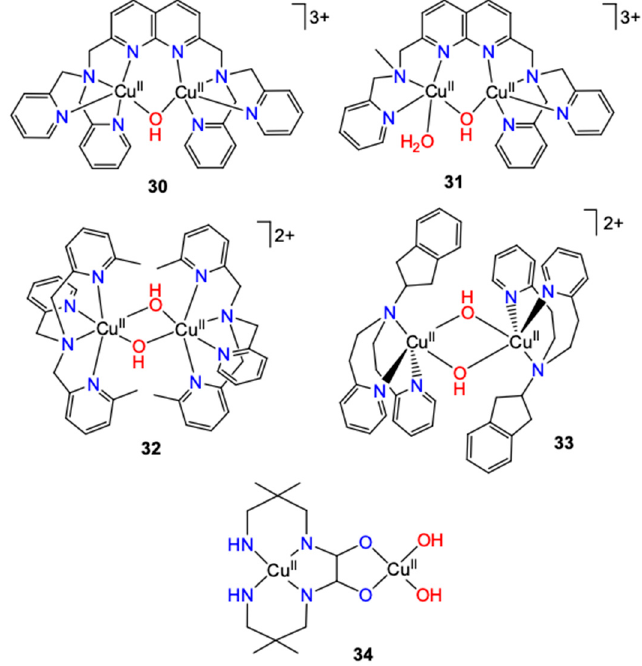
Figure 19. Molecular WOCs containing two copper centers.